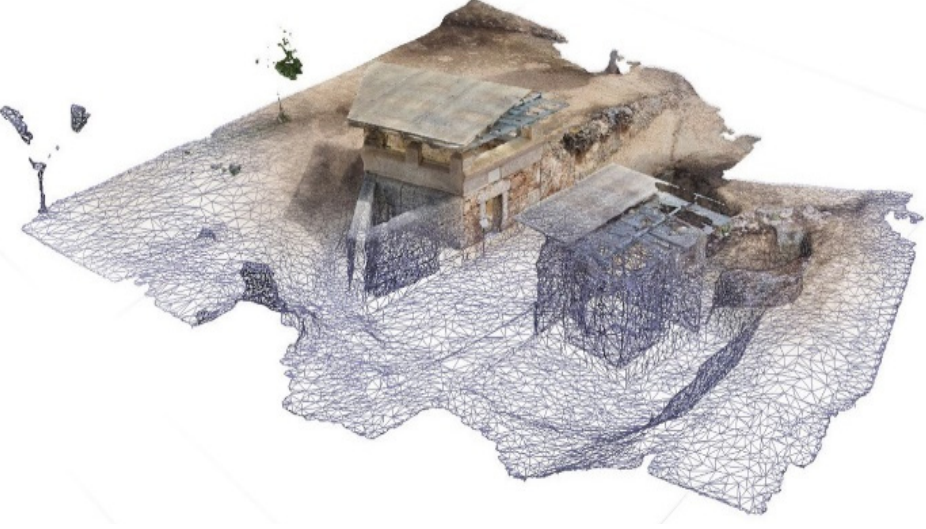
Figure 12. Mesh and texture generation with Photoscan.